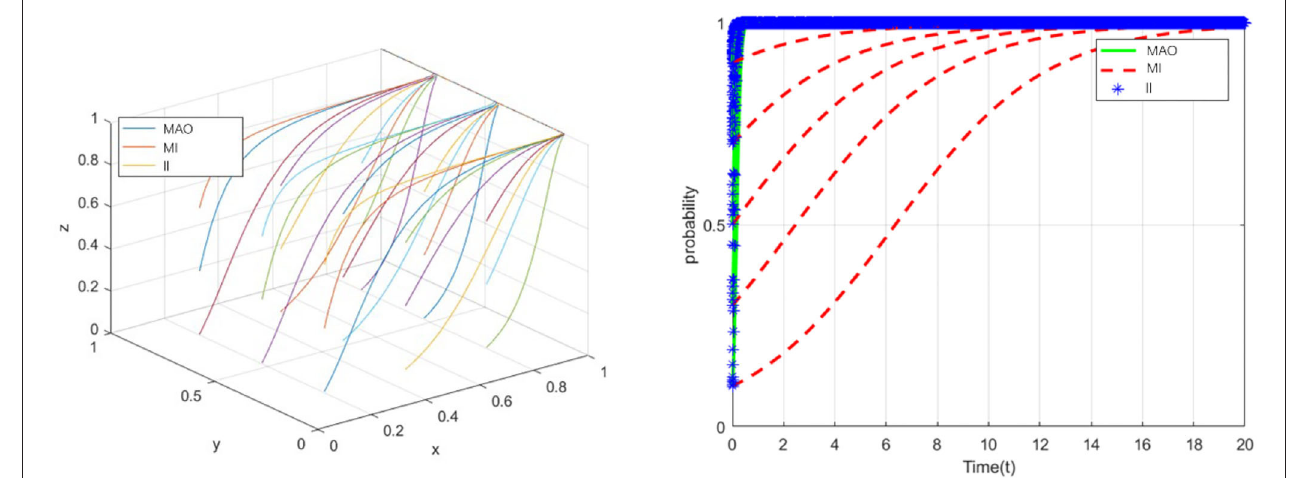
FIGURE 6 | The evolution toward the sink ESS